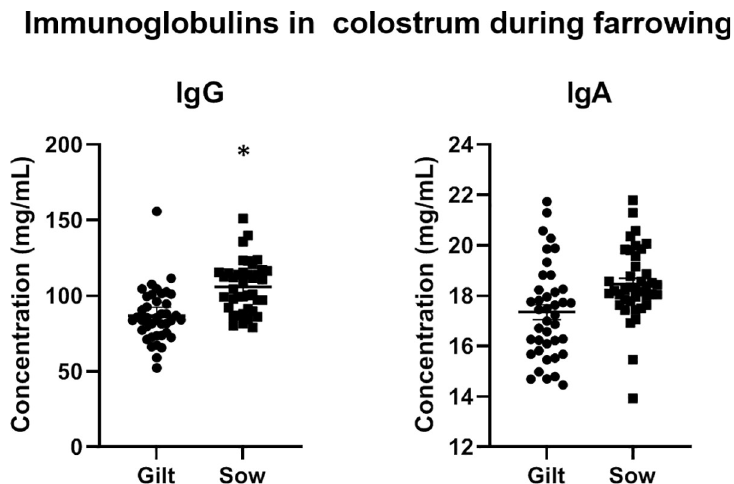
Fig 3. Comparison of total IgG and IgA concentration (mg/mL) in colostrum from gilts and sows. Error bars represent the standard error of the mean ( ± SEM). Gilt IgA (17.5 ± 1.8) vs. Sow IgA (18.3 ± 1.4), p < 0.1650; � Gilt IgG (90.0 ± 21.3) vs. Sow IgG (102.9 ± 21.6), p < 0.0112.